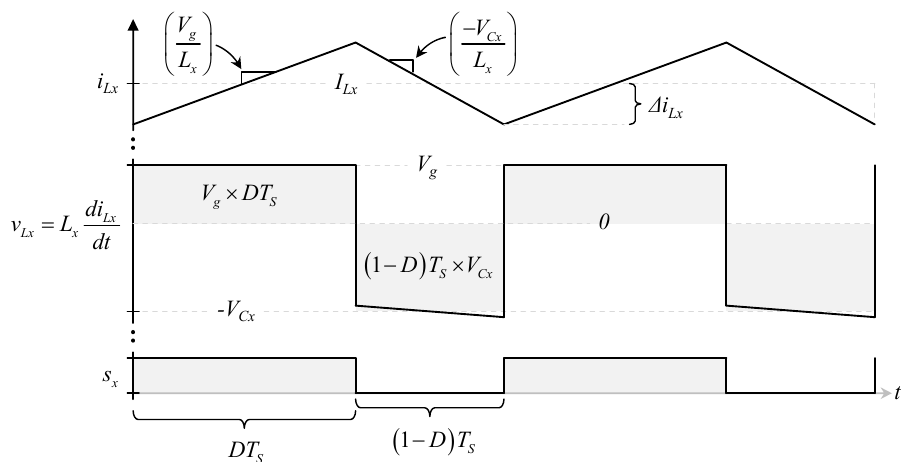
Figure 4. Important waveforms related to the inductor from top to bottom, respectively: inductor current, inductor voltage, and switching function.